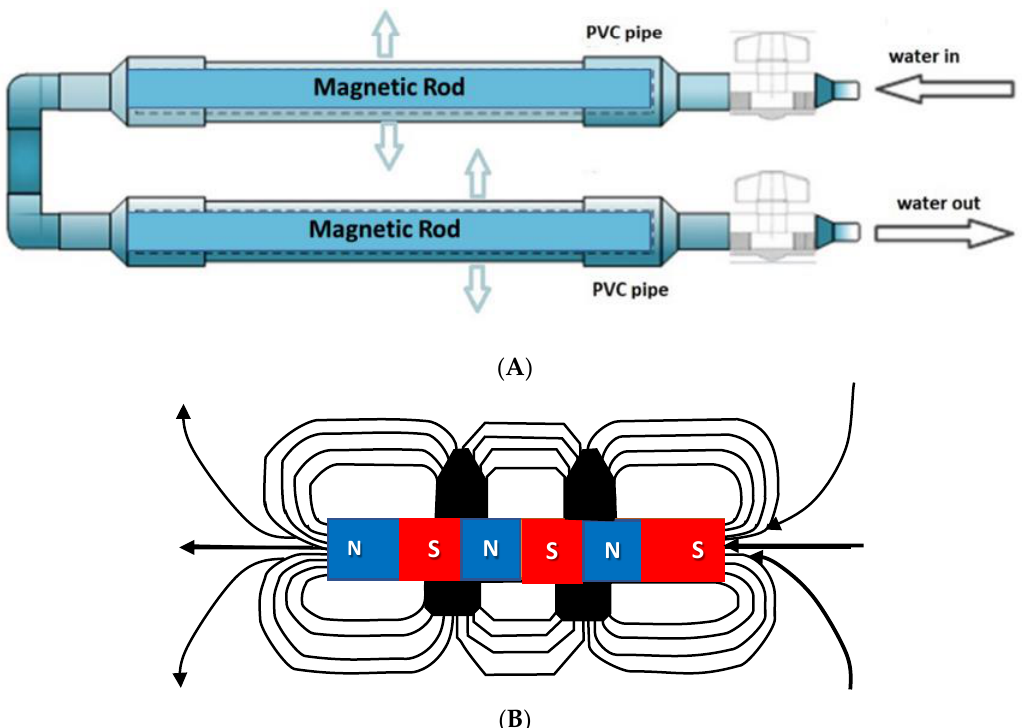
Figure 2. ( A ) Developed magnetic device for creating MTW. ( B ) is a schematic line diagram of the magnetic device showing their north and south poles, the direction of magnetic field generated, and water flow through the rod magnets in the PVC pipe .